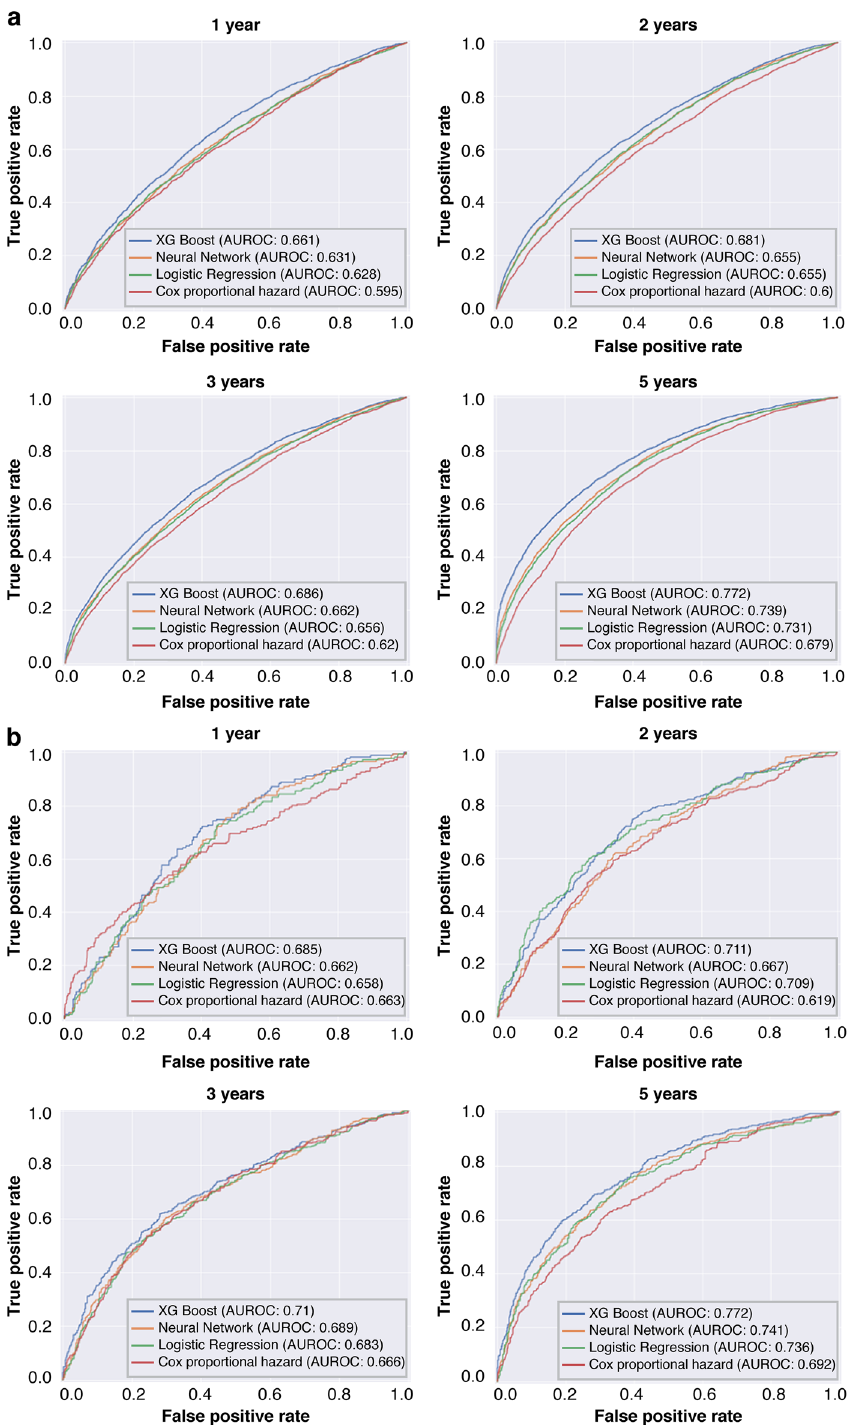
Figure 2. Performance of full prediction models with top 60 variables. ( a ) ROC curves of different types of models for predicting the risk of diagnosis of CKD/HF and ( b ) ROC curves of different types of models for predicting the risk of hospitalizations for CKD/HF. AUROC area under the receiver operating characteristic curve, CKD chronic kidney disease, HF heart failure, ROC receiver operating